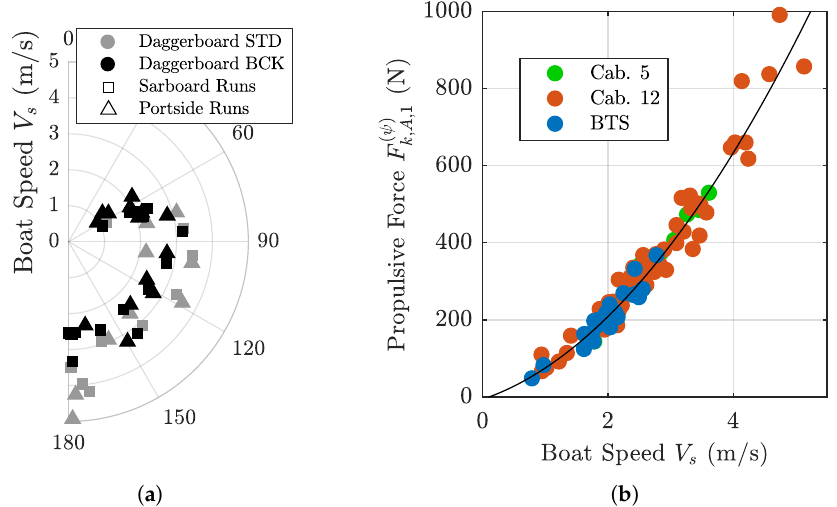
Figure 15. ( a ) Impact of the daggerboard choice on speed performances of the kiteboat according to the true wind angle (true wind speed from 4.5 to 6 m/s). ( b ) Overview of the running resistance curve of the kiteboat built from all runs completed during the trials. The colors are based on the kite used during each race. The black line denotes the best quadratic fitting applied on the entire cloud of